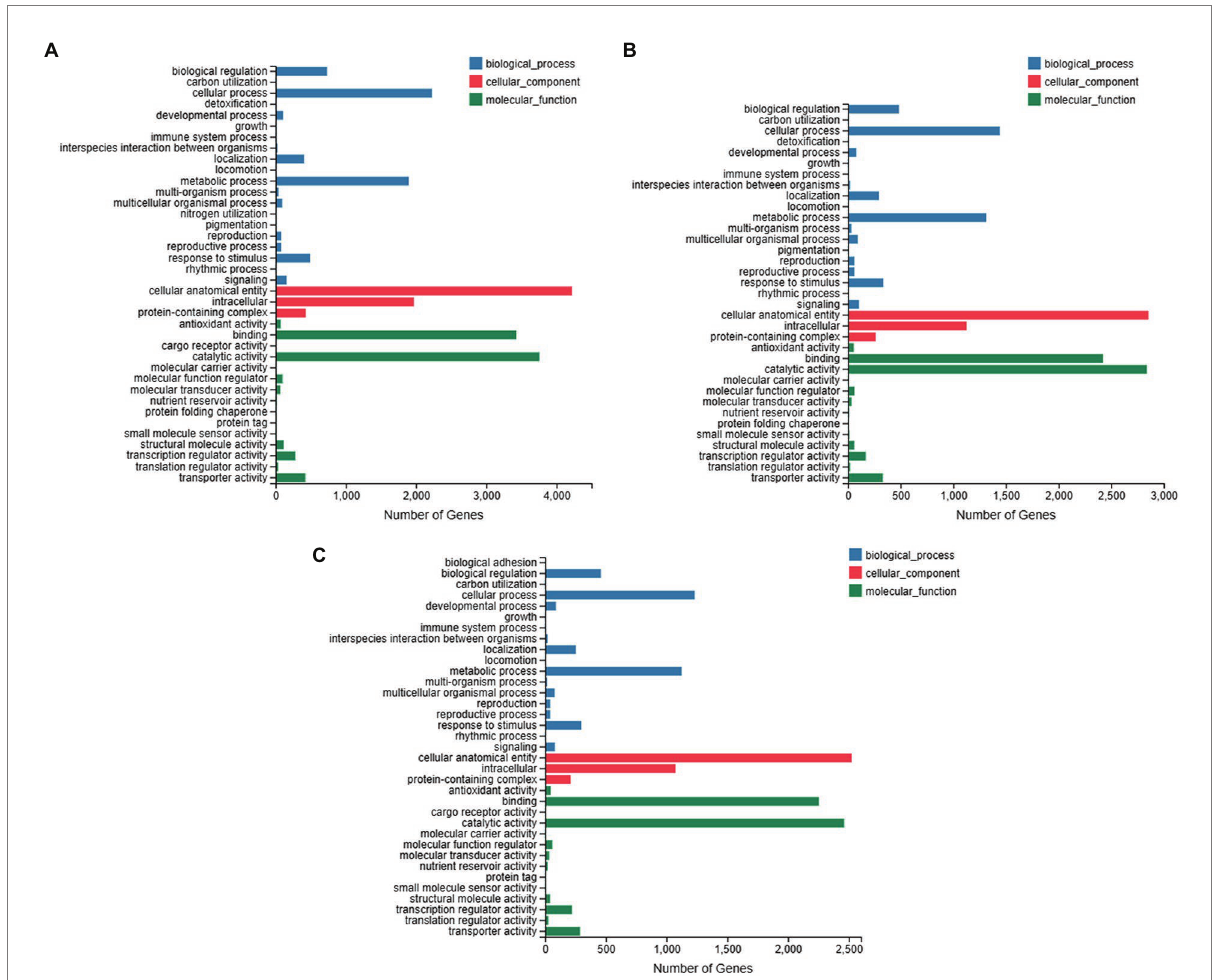
FIGURE 3 Overview of GO enrichments for C. ensifolium (A) , C. goeringii (B) , and C. sinense (C) . The DEGs enrichment is shown in three GO categories, including biological process, cellular component and molecular function. The y-axis shows the GO category and the x-axis shows the number of genes enriched to each